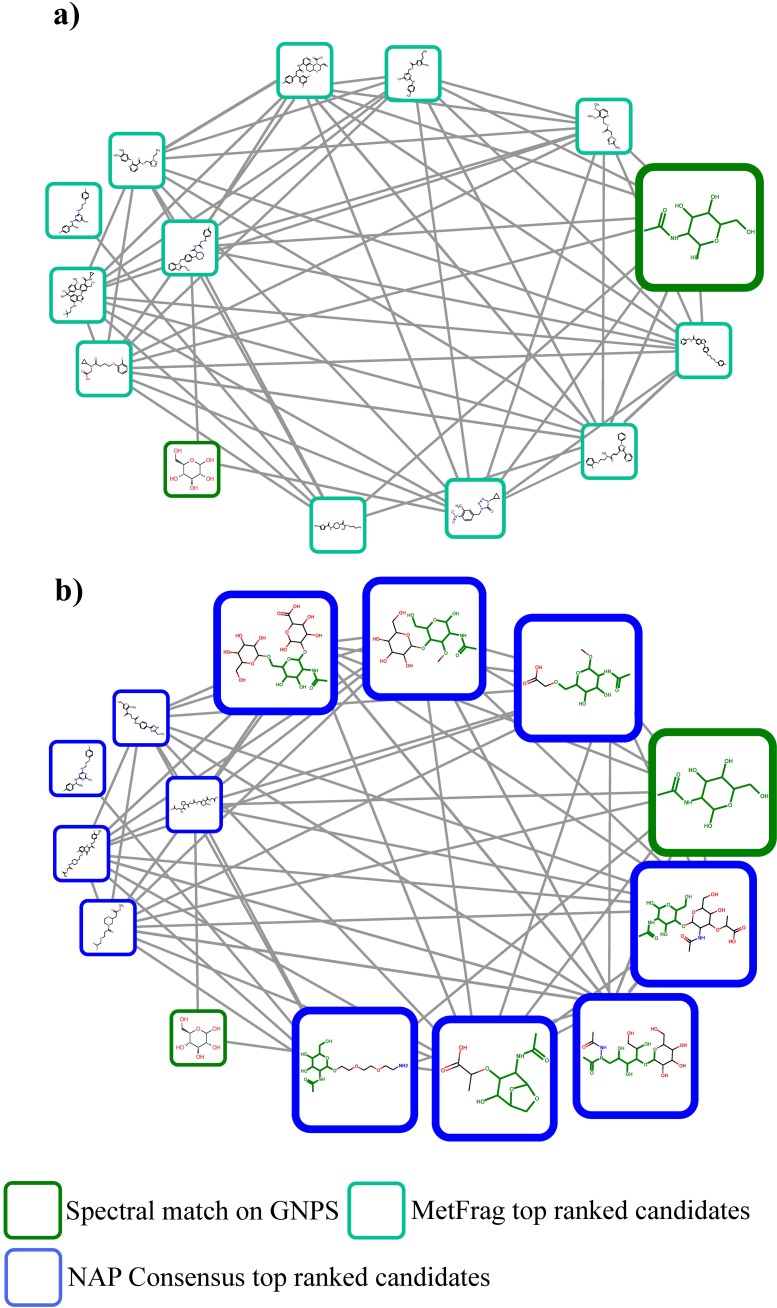
N-acetyl-sugar metabolite family: Annotations of library match to N-acetylgalactosamine propagates through network.N-acetylglucosamine containing top-ranked candidates are represented in larger boxes. a) Result from MetFrag b) Result from network Consensus. Highlighted in green is the maximum common substructure (MCSS) of each node to the reference library (green border node) for the seven N-acetylglucosamine related molecules.